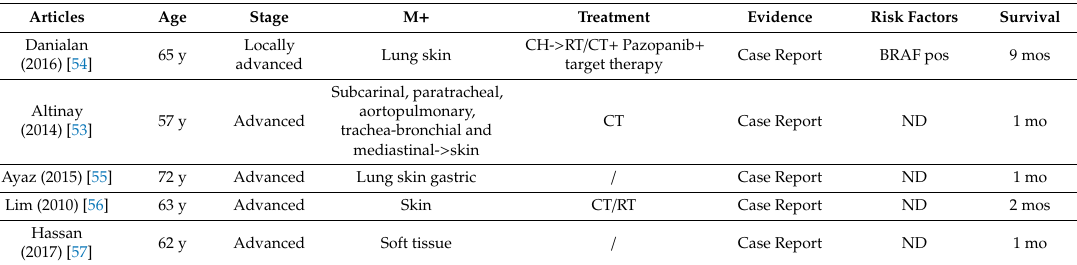
Table 2. Selection of articles regarding uncommon sites of ATC